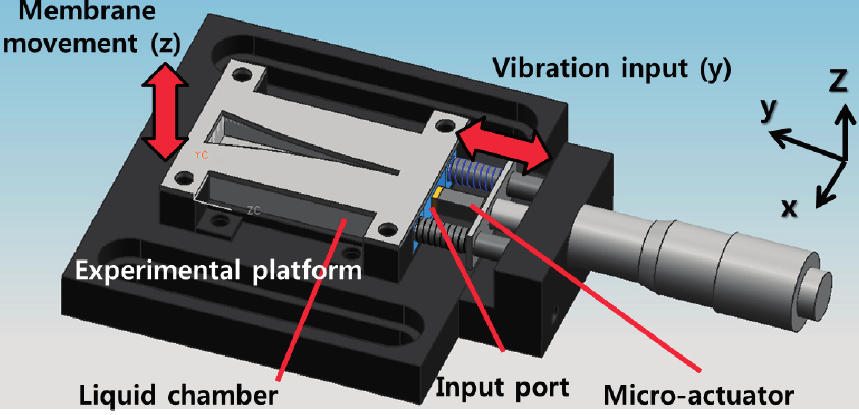
Figure 2. 3D drawing of packaged part of PAC with SUS frame of membrane part placed over the liquid